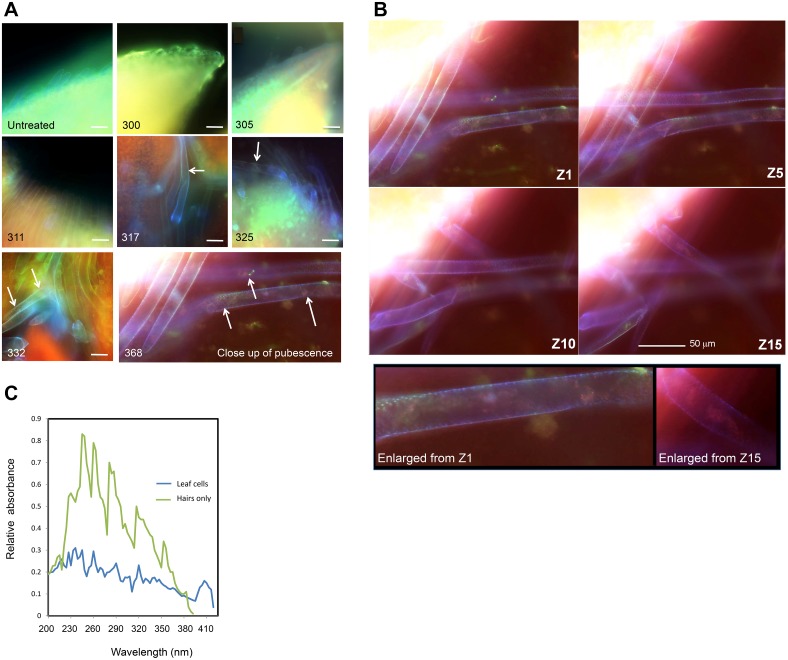
UV- and visible-light absorbing compounds are located in pubescence, induced by UV-A or UV-B or Phe. A. Responses of live-seedling pubescence to UV-B and UV-A wavelengths on deconvoluting microscopy.4-d dark grown seedlings were either mock-irradiated (Untreated) or irradiated with 104 µmolm−2 of UV (300, 305, 311, 317, 325, 332 or 368 nm shown), then returned to the dark for 24 h, after which the live primary leaves were imaged on a deconvoluting microscope. The images shown are captured (false-colored) for DAPI (blue), FITC (green) and TexasRed (red) excitation/emission sets (merged images shown) and show natural fluorescence, and represent a snap of the Z-stack focused on the abaxial pubescence of the primary leaf. At least 30 seedlings were viewed per condition. A close-up of the pubescence from 368 nm treatment is shown. Scale bar represents 40 µm. Arrows indicate the increasing (compared to Untreated) fluorescence. B. Z-stack representative slices of fluorescence of 368 nm treatment. Each slice of the Z stack = 1 µm thickness. C. Spectra of leaf material compared to pubescence. Soybean were grown in complete darkness, irradiated with the wavelength as shown on the Figure at 4-d-old, then primary leaf pairs were harvested from seedlings into liquid nitrogen, where pubescence was separated then extracted for aqueous UV-absorbing molecules. Absorbance was read from 200–420 nm. Spectra are representative. n = 3 of sets of 30 seedlings each.